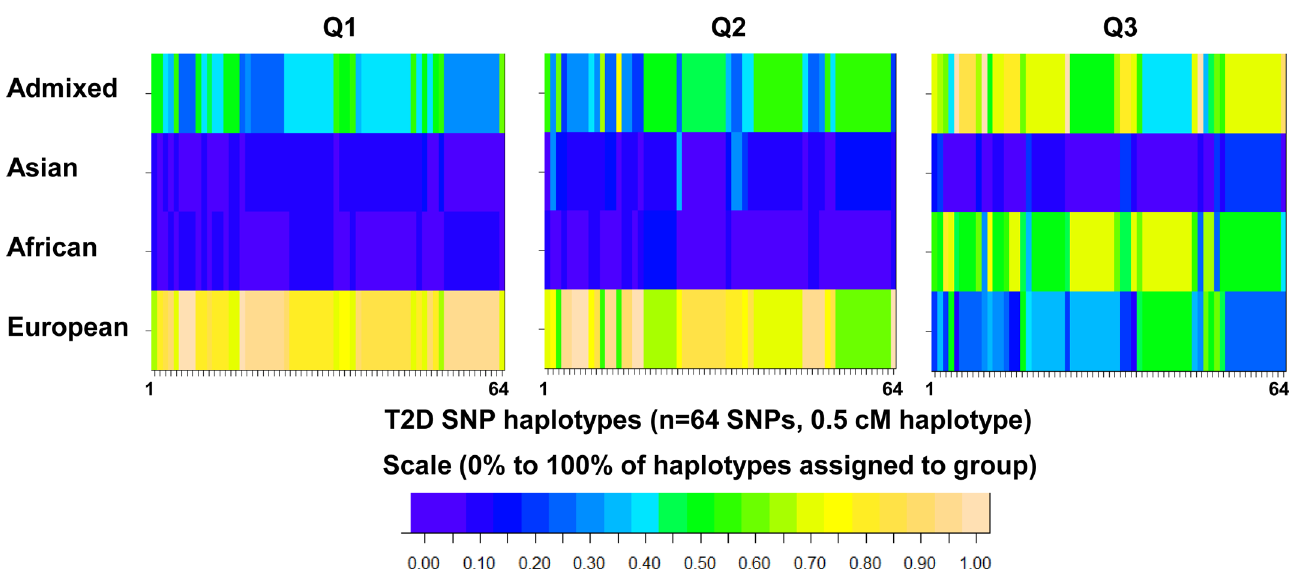
Fig 1. Comparison of Qatari haplotypes in the regions flanking known single nucleotide polymorphisms (SNPs) associated with type 2 diabetes (T2D) or nearby tag SNPs to the relevant haplotypes of European, Asian, African, or Admixed 1000 Genomes populations. Admixture deconvolution was used to determine if Qatari haplotypes flanking 64 ‘ T2D SNPs ’ matched the populations where these SNPs were discovered. Haplotypes were inferred for 100 deeply sequenced Qatari genomes (n = 60 Bedouin Q1, n = 20 Persian Q2, n = 20 African Q3), and divided into 2000 SNP (0.5 cM) intervals. For each interval, SupportMix [12] was used to infer the population with the most similar haplotype, using 1000 Genomes Project Phase 1 as a reference (Admixed = ASW, PUR, CLM, MXL; Asian = CHB, CHS, JPT; African = LWK, YRI; European = TSI, IBS, CEU, FIN, GBR). For each interval containing a T2D risk SNP (n = 64, S1 Table), the percentage of Qatari haplotypes assigned to European, Asian, African, or Admixed was determined. Shown is a heatmap of the results, where each column represents a SNP, and each row represents a 1000 Genomes group. Scaled from blue (0%) to tan (100%), colors represent the % of haplotypes for the SNP that are most similar to each Qatari population (Q1, Q2, or Q3).